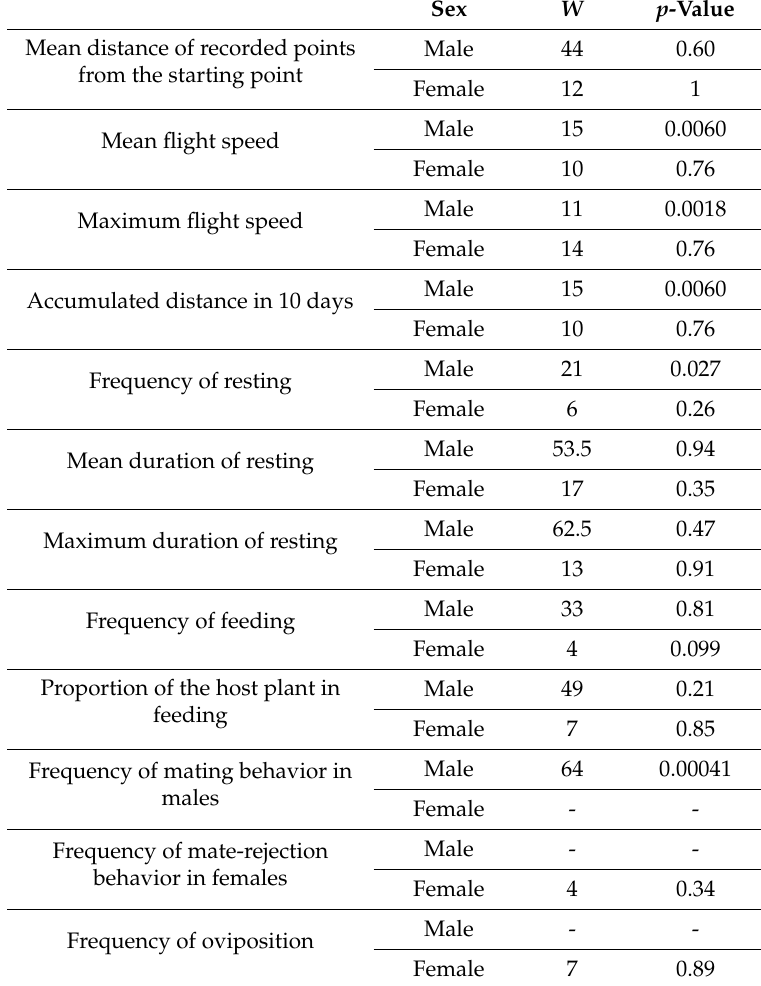
Table A1. Values of the U test between the two subspecies of Z. maha .